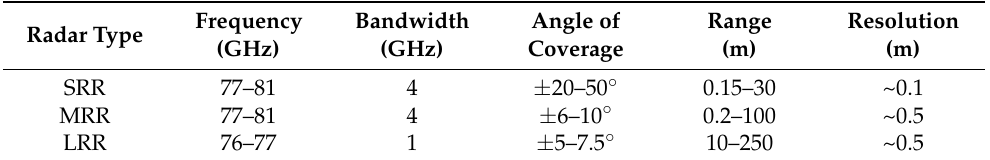
Figure 1. Applications of radars in vehicles for adaptive cruise control (ACC), automatic emergency braking (AEB), left side (LS) and right side (RS) blind spot detection (BSD), collision mitigation (CM), cross traffic alerts (CTAs), forward collision warning (FCW), and lane change assistants (LCAs). Table 1. Typical specifications of automotive radars [2].